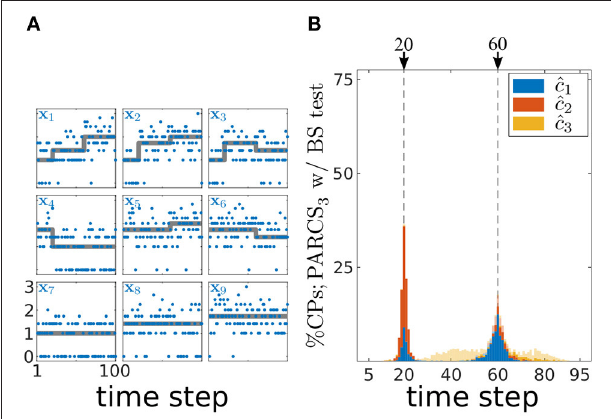
FIGURE 8 | Multiple CP detection in spatially independent, multivariate, Poisson data; (A) deterministic component of the different covariates in the time series (gray) superimposed on an exemplary time series (blue); y -axis, square-root-transformed spike counts; (B) stacked histograms of correct detection rates over 1,000 realizations; transparent bars show candidate CPs excluded by the permutation test; dashed gray, ground truth